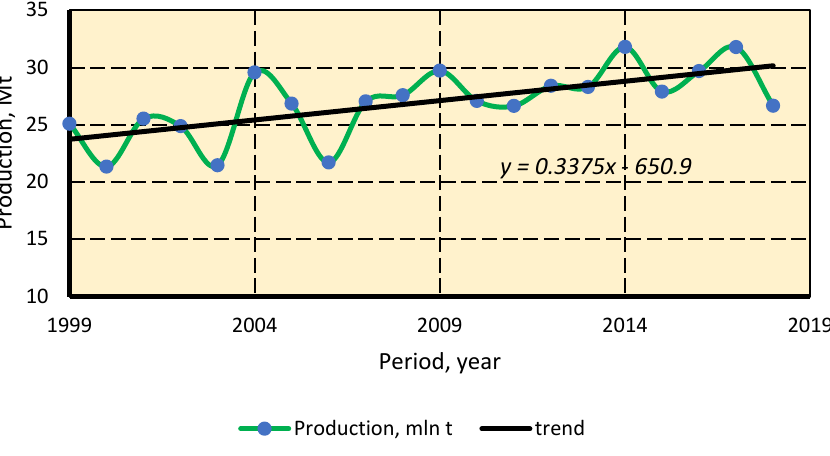
Figure 2. Total cereal production. Table 1. Average, minimum and maximum grain crop harvests over the past 20 years, Mt (from 1999 to